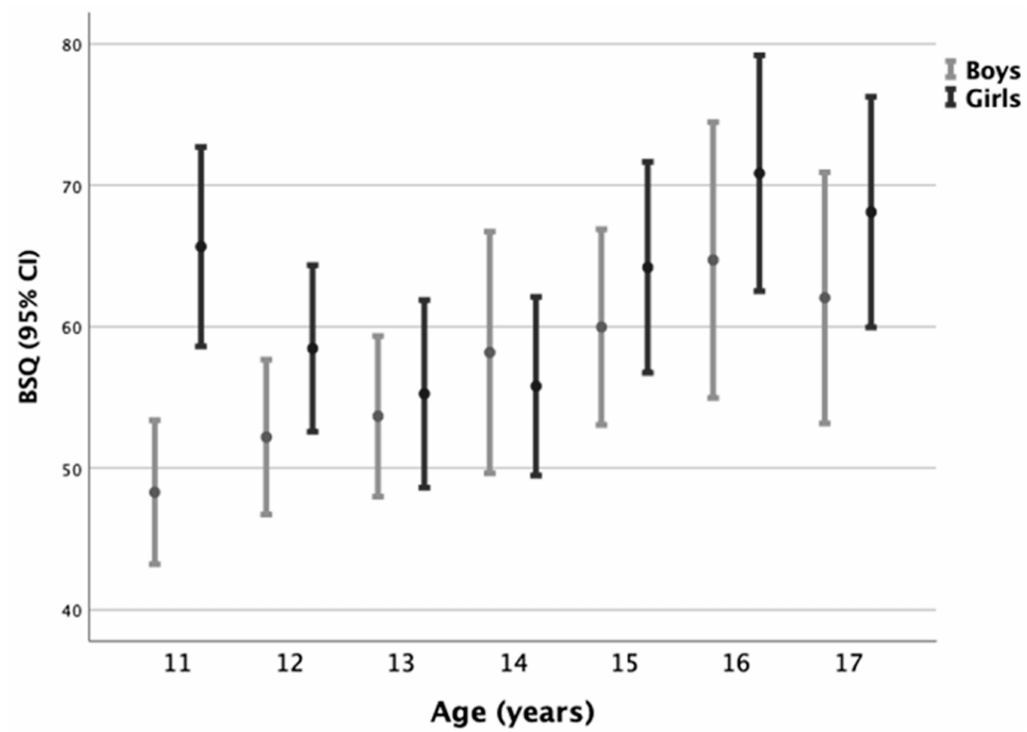
Figure 2. Body Shape Questionnaire (BSQ) mean scores at the different ages according to sex (Dots = mean values; CI = confidence interval). Table 2. Correlations between BSQ scores and anthropometric variables (BMI = body mass index, FMI = fat mass